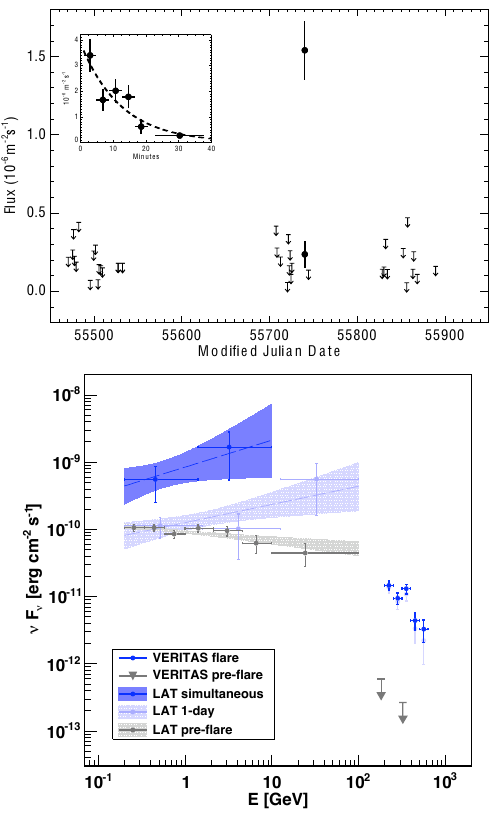
Figure 6. (a) (Top) VERITAS lightcurve of BL Lac in June 2011 ( > 200 GeV). The inset shows the day scale variability in BL Lac. For details see [19]. (b) (Bottom) Broadband gamma-ray spectrum of BL Lacertae. For VERITAS, the flare spectrum with EBL correction is shown as blue points, with uncertainties, and the spectrum without EBL correction is shown as lighter blue points. The Fermi -LAT data shows hardening of the spectrum during the flare. (Both figures are taken from